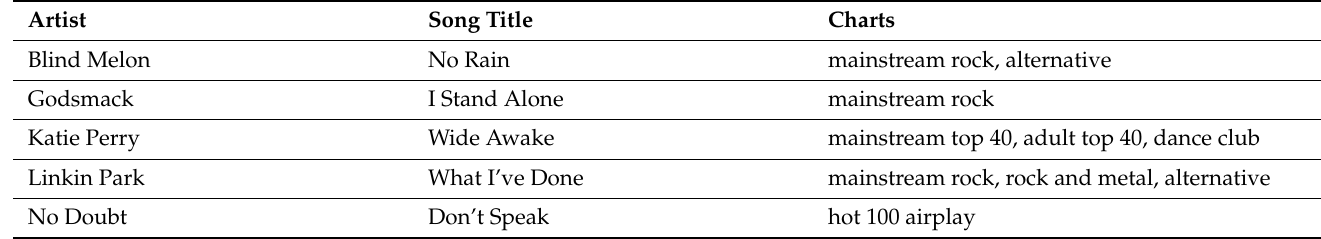
Table 3. Chart-topping songs having music videos featuring